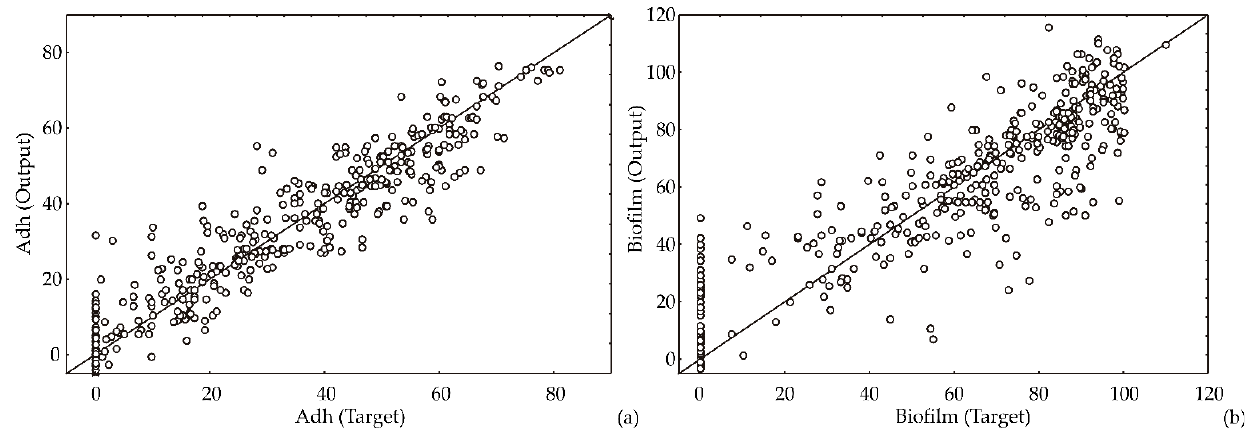
Figure 2. Experimental and predicted values obtained for ( a ) inhibition of adhesion and ( b ) inhibition of the biofilm-forming process.